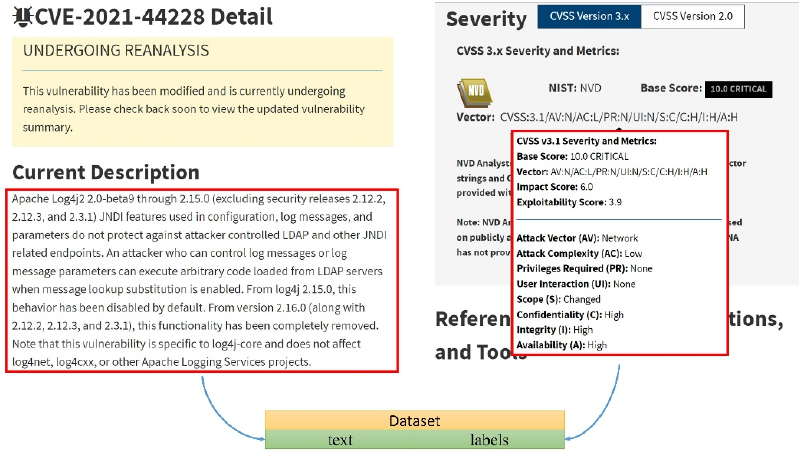
Figure 4. Dataset collection